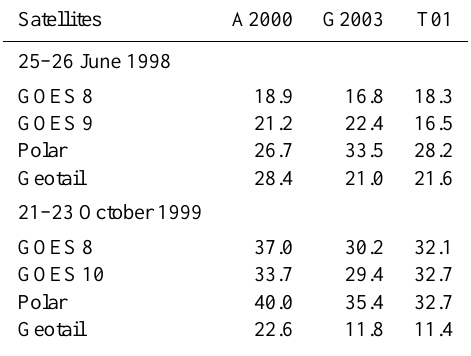
Table 1. The RMS deviations in nT between the observed and mod- elled magnetic field calculated by the paraboloid (A2000, Alexeev et al., 2001), event-oriented (G2003, Ganushkina et al., 2003), and Tsyganenko (T01, Tsyganenko, 2002a,b) models during magnetic